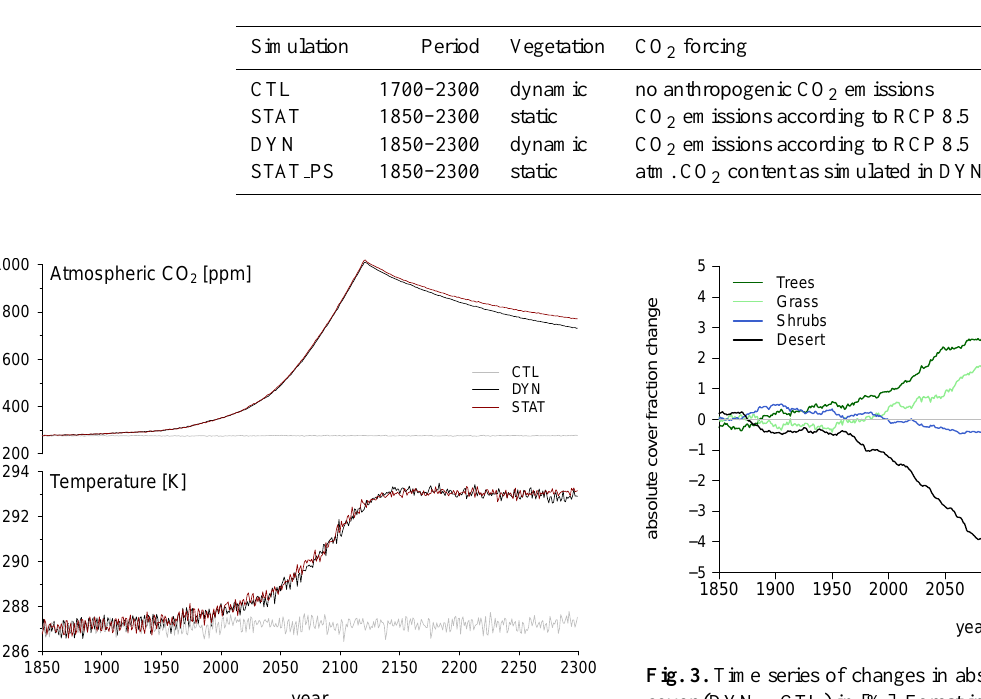
Table 2. Experimental setup. The used CO 2 emission scenario is based on the RCP 8.5.